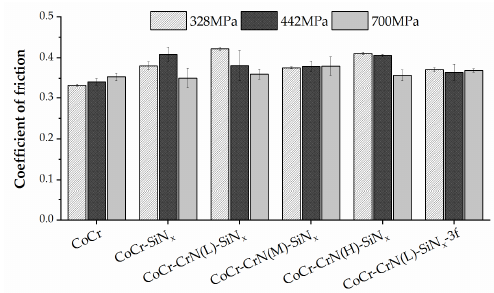
Figure 3. Coefficient of friction at estimated contact pressures of 328 and 442 MPa, using a ball diameter of 20 mm, with applied loads of 1 and 2.45 N, respectively. The coefficient of friction at an estimated contact pressure of 700 MPa is also included, using a ball diameter of 10 mm and an applied load of 2.44 N.